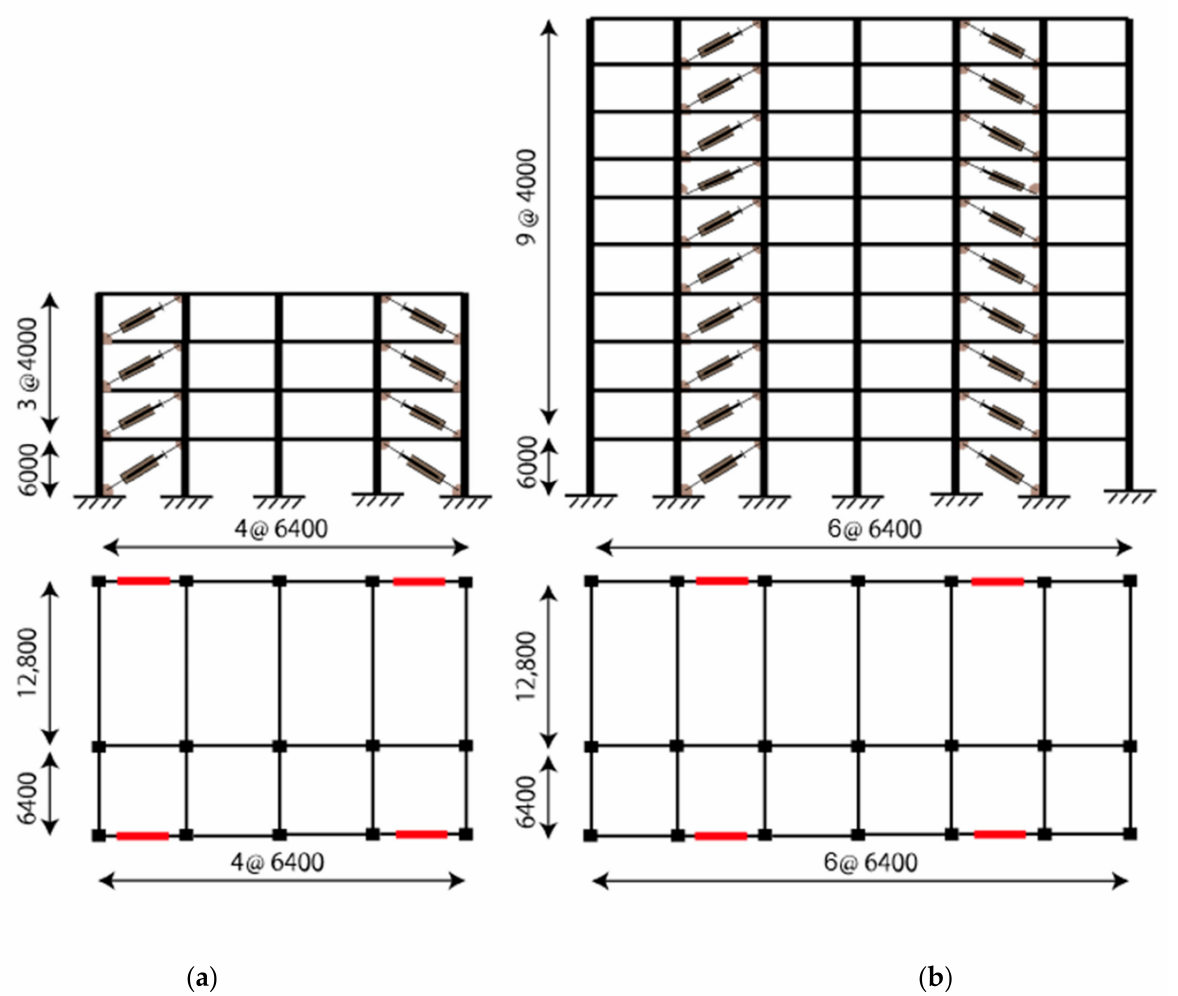
Figure 6. Target buildings plan, elevation and oil damper configuration: ( a ) 4-story building; ( b ) 10-story